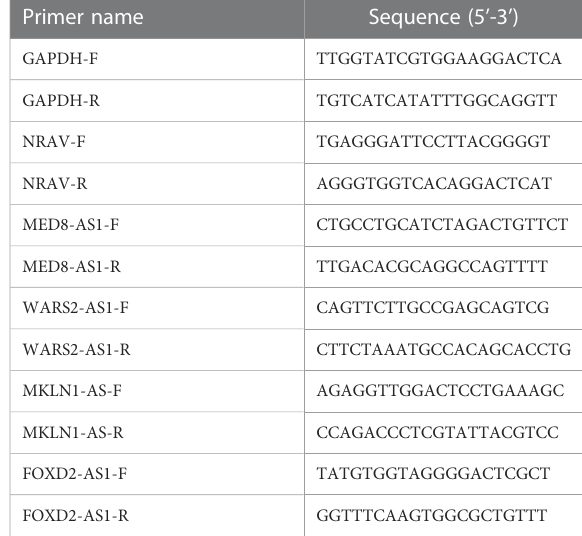
TABLE 2 Primers used in this study.